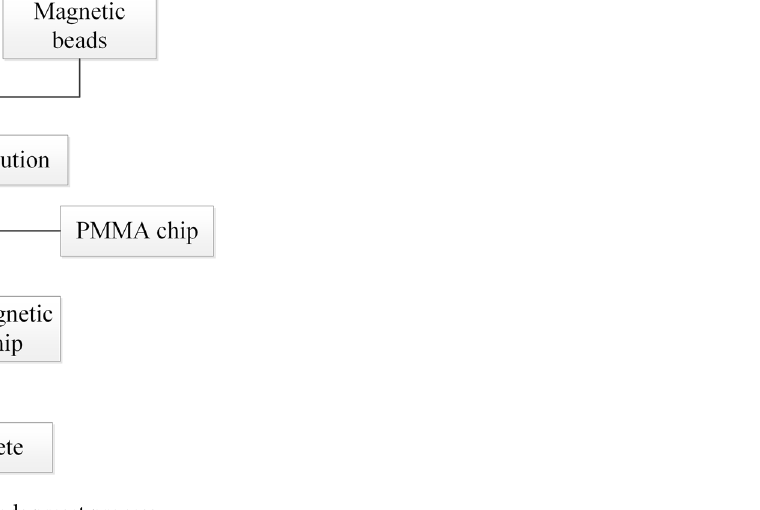
Figure 3. Magnetic beads preset